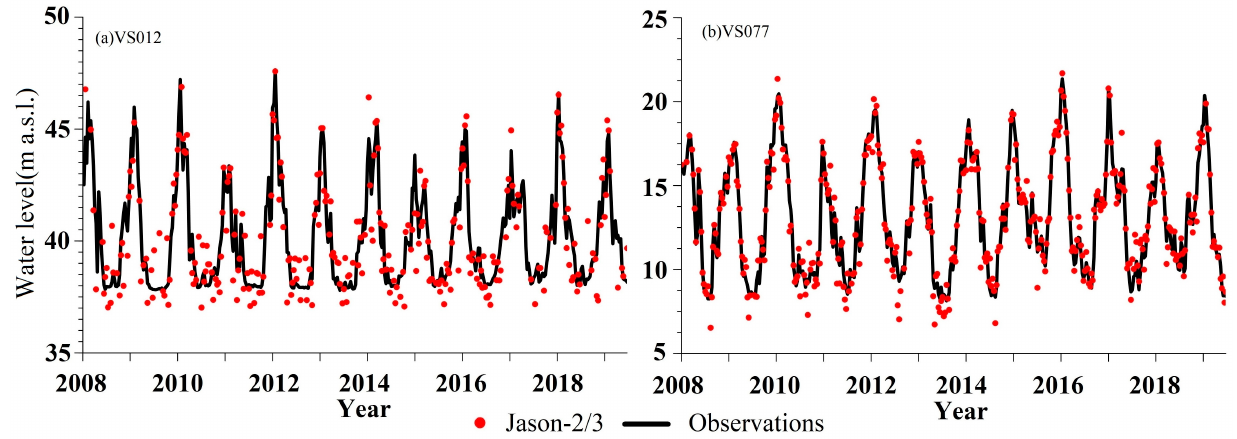
Figure 4. Water level retrievals (m a.s.l.) of satellite radar altimetry at ( a ) VS012 and ( b ) VS 077 between 2008 and 2019.